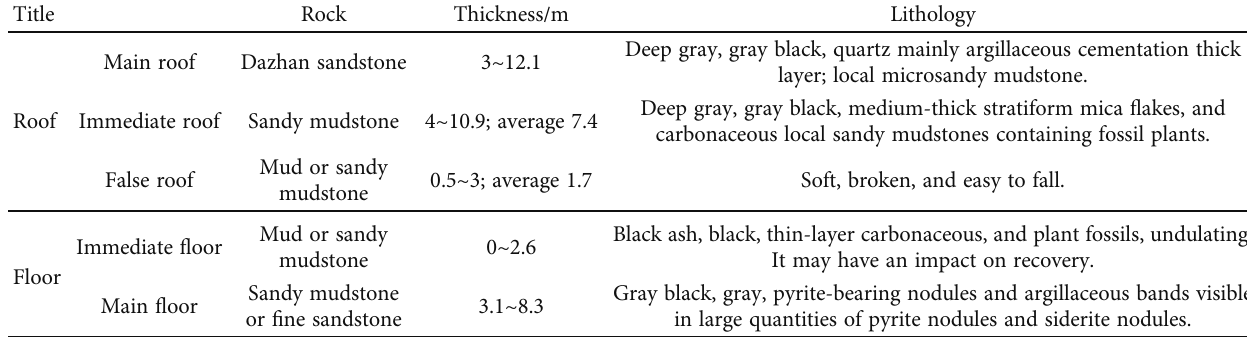
Table 1: Lithology of roof and fl oor slate of coal seam in 12090 working